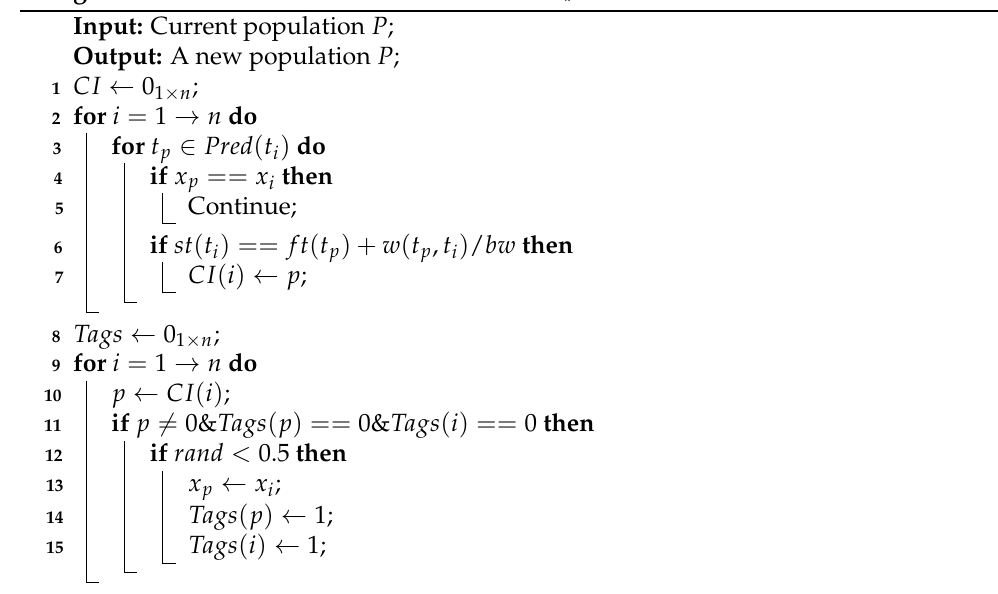
Algorithm 3: Function